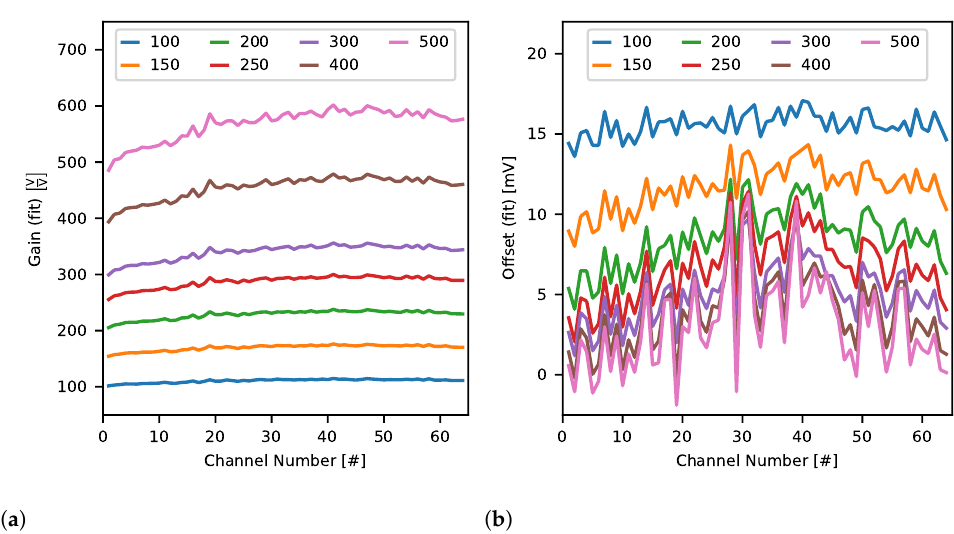
Figure 19. Measurement of channel ( a ) gain and ( b ) offset based on the relationships between stimulation output current amplitude and recorded signals’ amplitude.